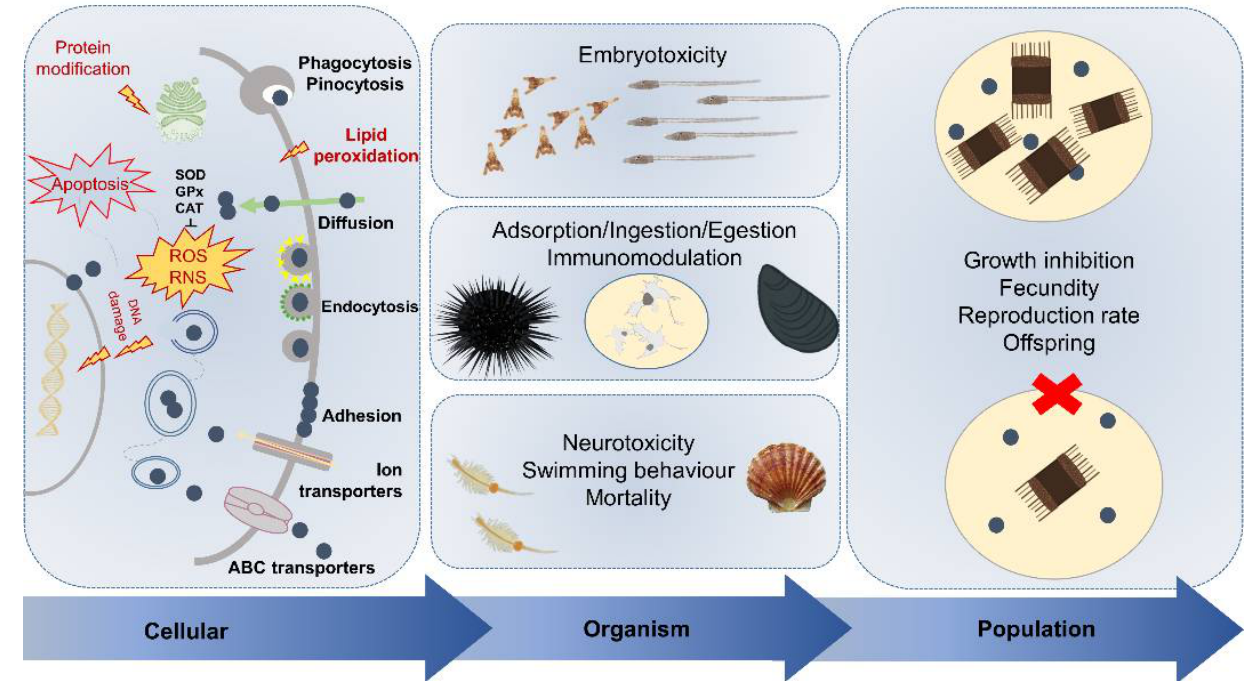
Figure 6. Conceptual representation of the known toxicological responses to ENMs across marine model species and at different levels of organization, ranging from single cells ( left ), individuals ( middle ) up to populations ( right ). ENMs are displayed as dark blue dots.